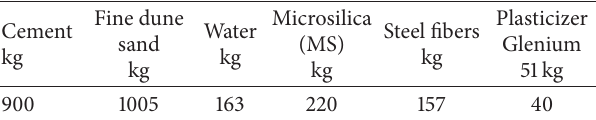
Table 6: Quantities of constituents for producing 1m 3 of the base UHPC mixture.